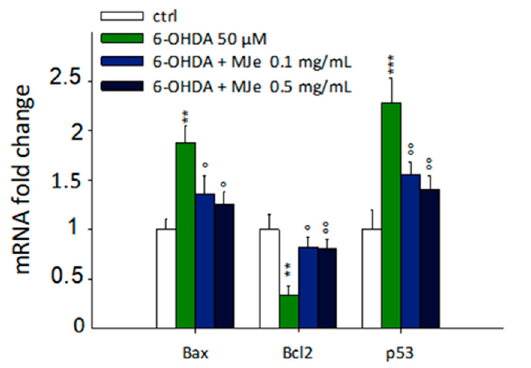
Figure 4. Protective effect of MJe on mRNA levels of apoptosis-related genes modulated by 6-OHDA. SH-SY5Y cells were pretreated with MJe for 1 h and then exposed to 6-OHDA 50 µ M for additional 24 h and then assessed with real-time PCR. The 2 – ∆∆ CT method was employed to calculate the relative quantities of mRNA. Results are expressed as fold change relative to untreated cells. Data, expressed as mean ± SEM, represent the values obtained in three different sets of experiments in triplicate (N = 9). ** p < 0.01, *** p < 0.001 vs. control; ◦ p < 0.05, ◦◦ p < 0.01 vs. 6-OHDA 50 µ M.